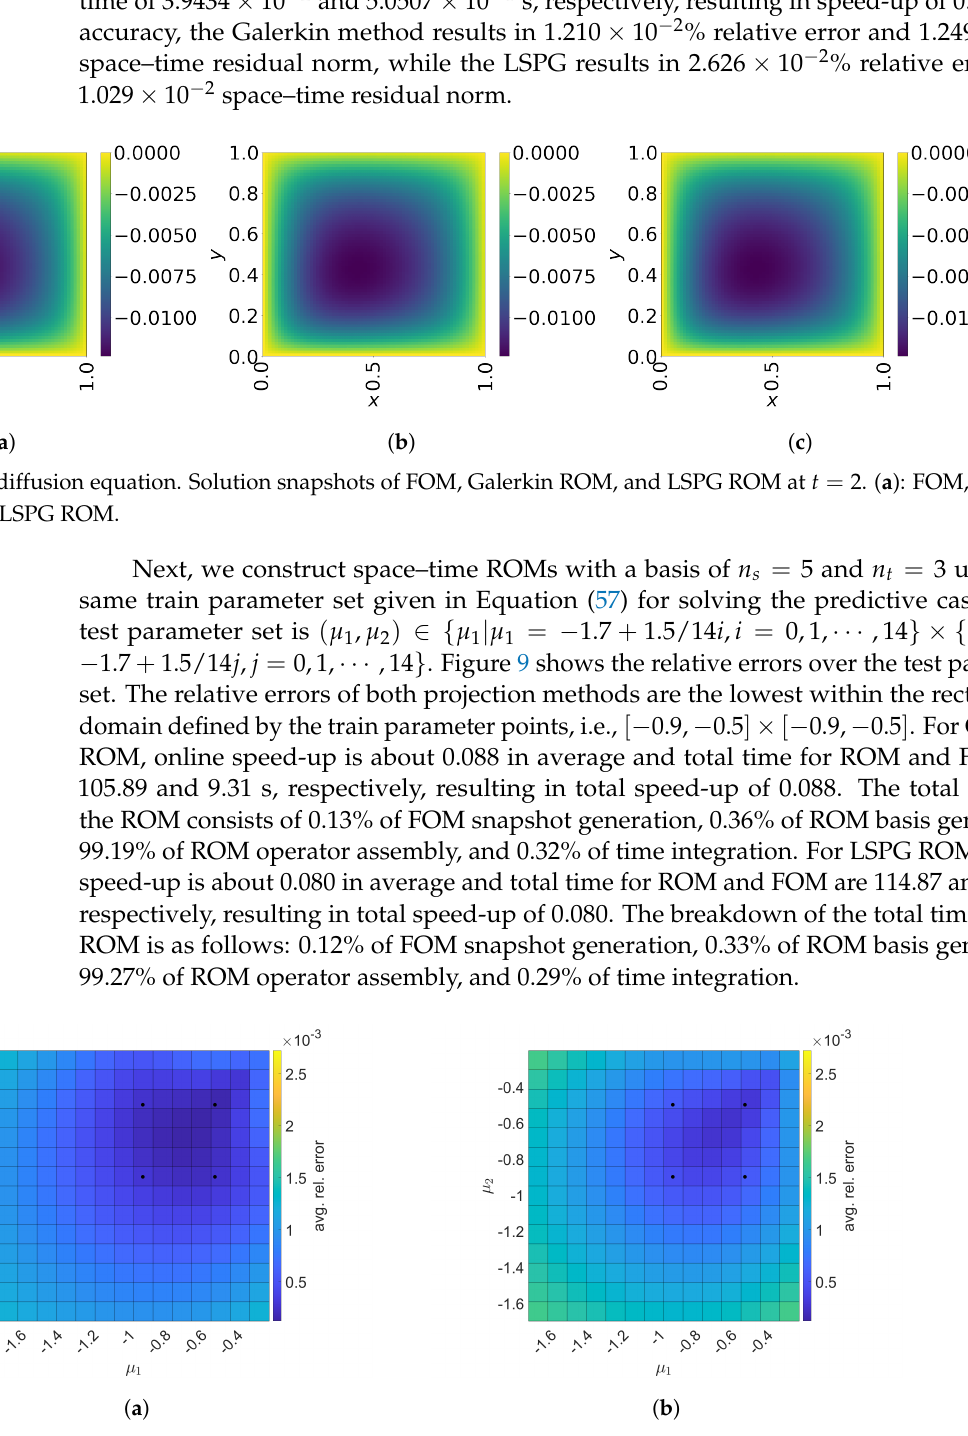
Figure 9. 2D linear diffusion equation. The comparison of the Galerkin and LSPG ROMs for predictive cases. The block dots indicate the train parameters. ( a ): Galerkin, ( b ):